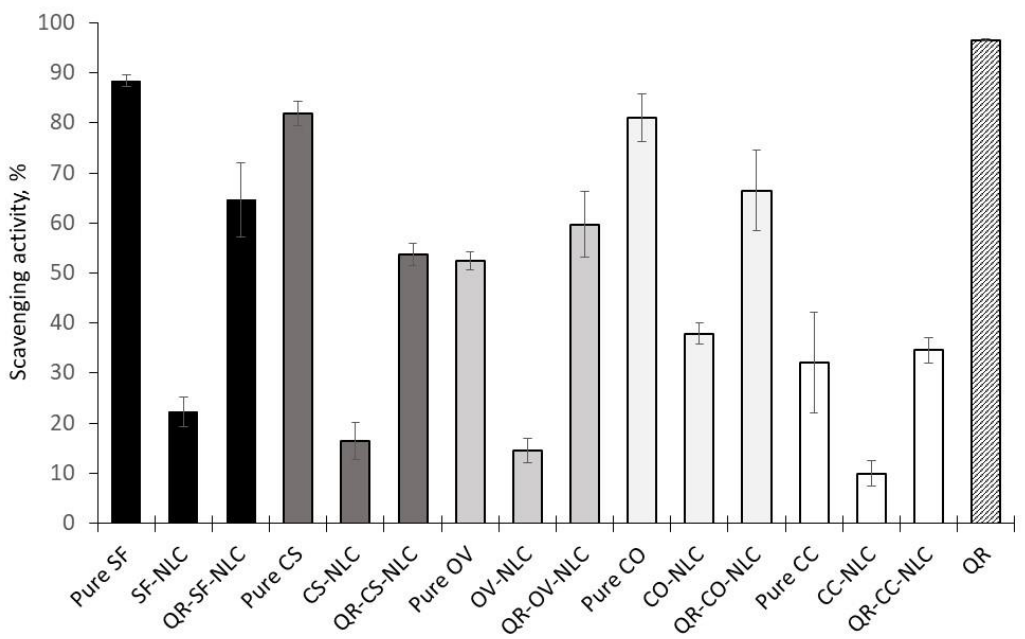
Figure 7. Antioxidant activity of pure plant oils used in the preparation of the lipid nanoparticles of the QR-free NPO-NLCs, QR-NPO-NLCs (0.5 wt%), and of a pure QR solution (2.5 mg mL − 1 ).